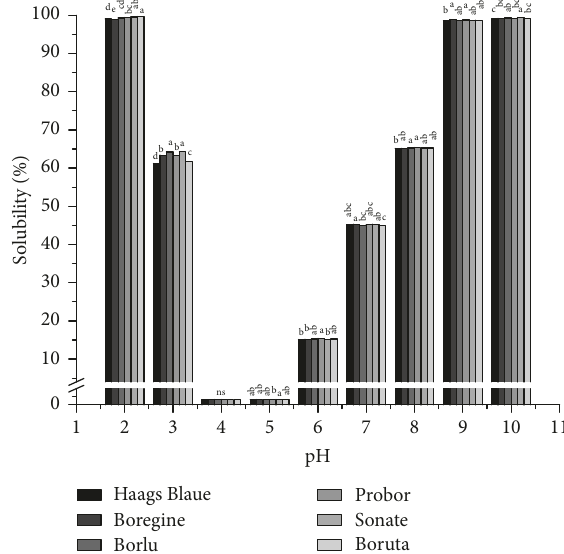
Figure 1: Effect of pH on the solubility of six varieties of Lupinus angustifolius protein isolates. Different letters indicate significant differences among varieties at 𝑃 < 0.05 ; ns indicates nonsignificance ( 𝑃 > 0.05